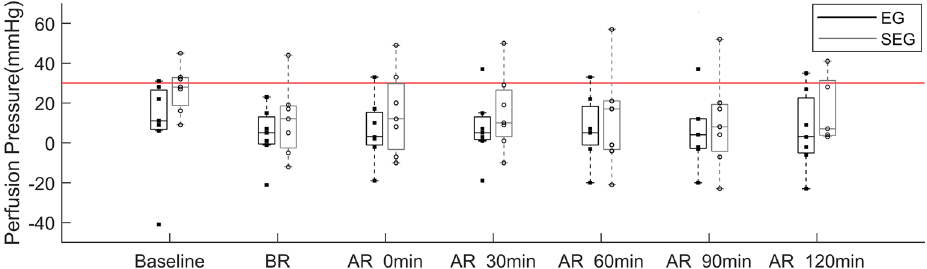
Figure 1. Perfusion pressure of the experimental leg between the EG (black bar plot) and SEG (gray bar plot) at each time point (Baseline, BR, AR_0 min, AR_30 min, AR_60 min, AR_90 min, and AR_120 min). Each dot indicates each data point in each group. Each bar plot indicates 25th (Q1), 50th (Q2), and 75th (Q3) percentiles of the data. The whisker indicates Q3 + 1.5 × (Q3–Q1), and Q1 − 1.5 × (Q3–Q1). The red line indicates the 30 mmHg showing the cut-off value for the induced CS (< 30